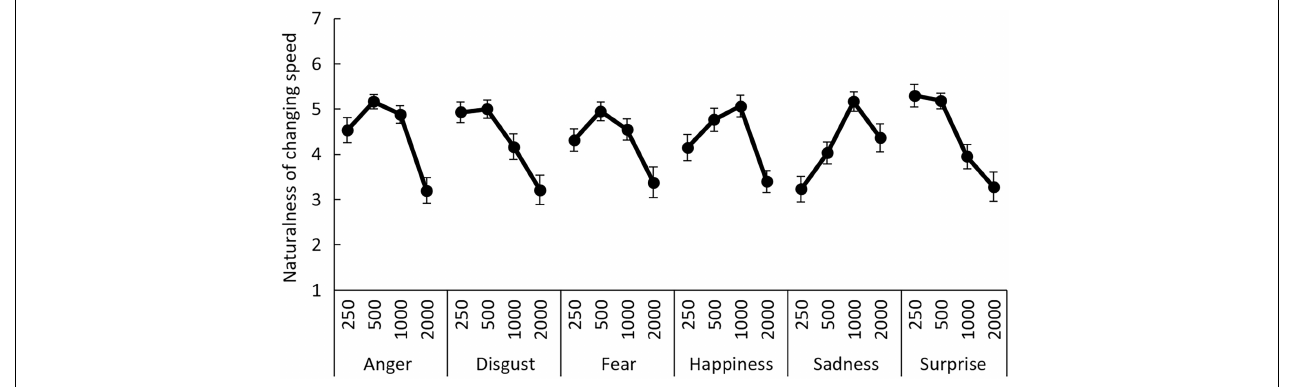
FIGURE 5 | Mean ( ± SE ) naturalness ratings for facial expressions of six emotions under the four speed conditions in Study 3.